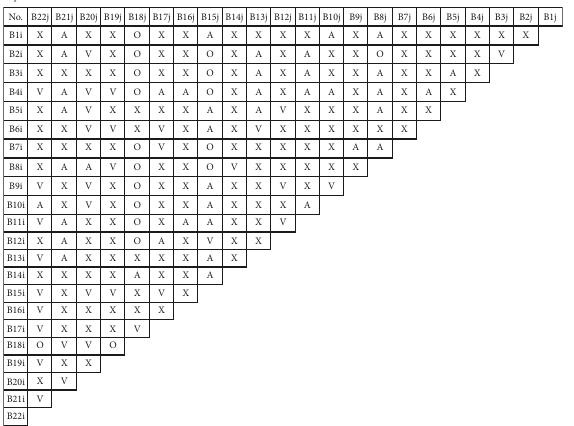
Table 4: ISSM from expert 6.